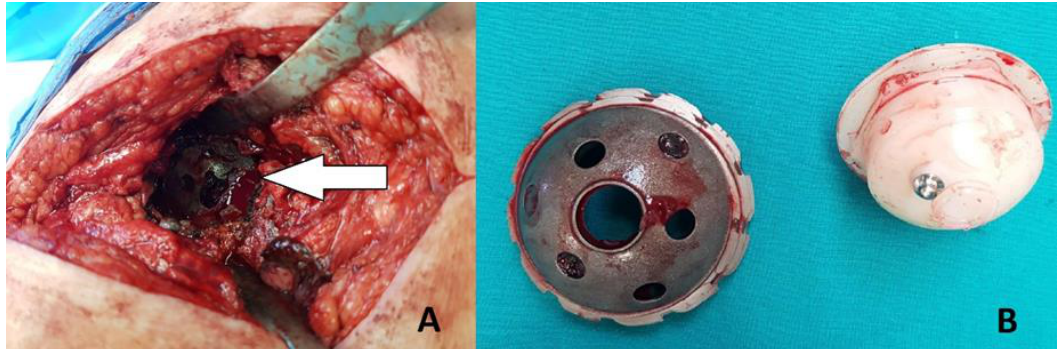
Figure 1. ( A ) Intraoperative photograph showing the porous coating of the acetabular component well-fixed in the acetabulum along its whole surface (white arrow). ( B ) Removed acetabular component devoid of its porous coating and the corresponding polyethylene insert.